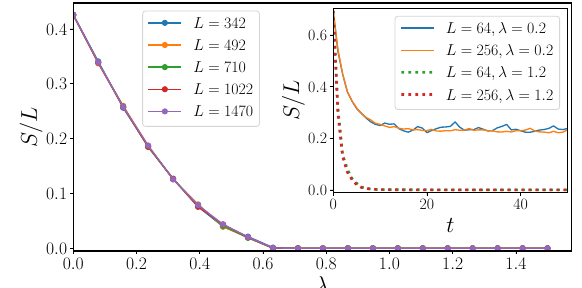
FIG. 3. The late-time entropy density S / L for a density matrix that is initially in a completely mixed state [i.e., ρ( t = 0 ) ∝ I ] and is evolved with the nonunitary circuit defined in Eq. (5). Inset: time evolution of S / L